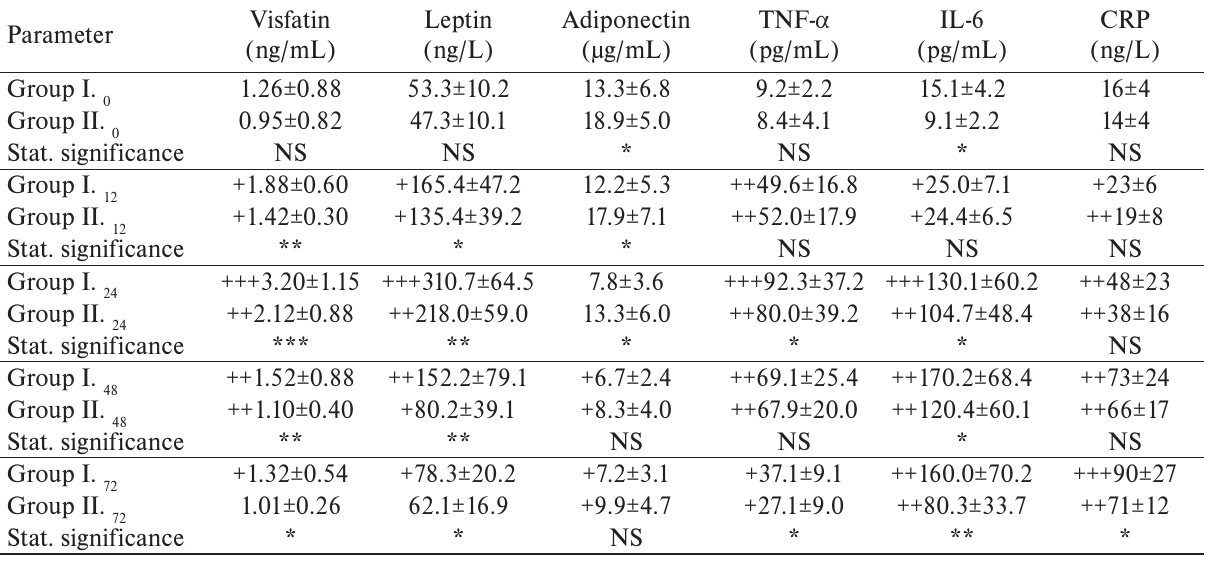
Table 3. Dynamics of selected parameters in Group I and Group II before and after surgery (0-12-24-48-72 h). Parameter Group I. 0